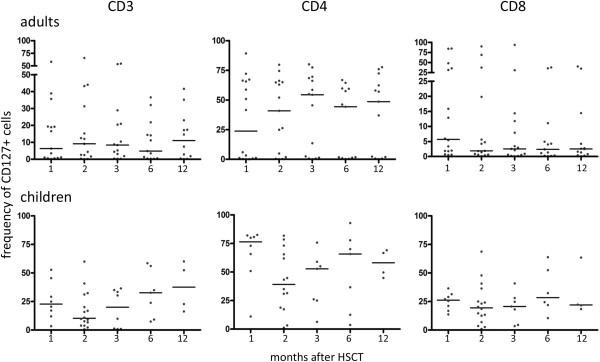
Percentage of CD127+ (IL-7R+) T-cells in patients after HSCT. Blood was taken at different time points after HSCT and CD127 expression was analyzed by flow cytometry on CD3+, CD3+CD4+, and CD3+CD8+ T-cells in PBMCs from adults and children.